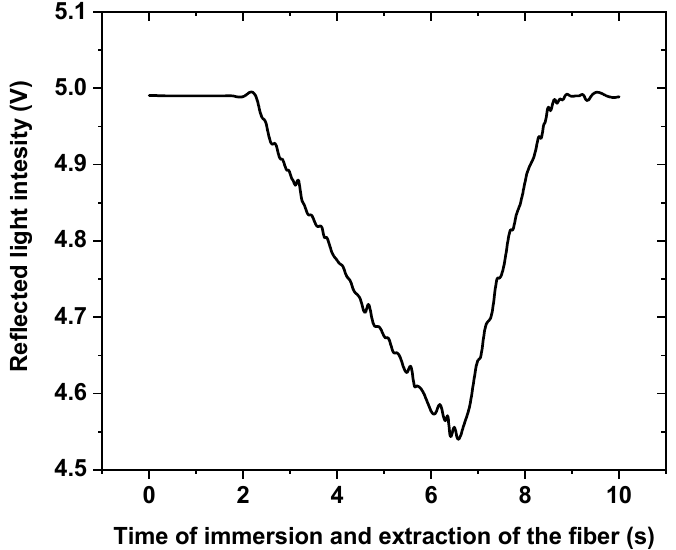
Figure 7. Depiction of the voltage signal provided by the Arduino while the detector registers the voltage variation recorded in the process of immersing the fiber and removing the fiber from one of the selected liquids (P3 oil in this case).